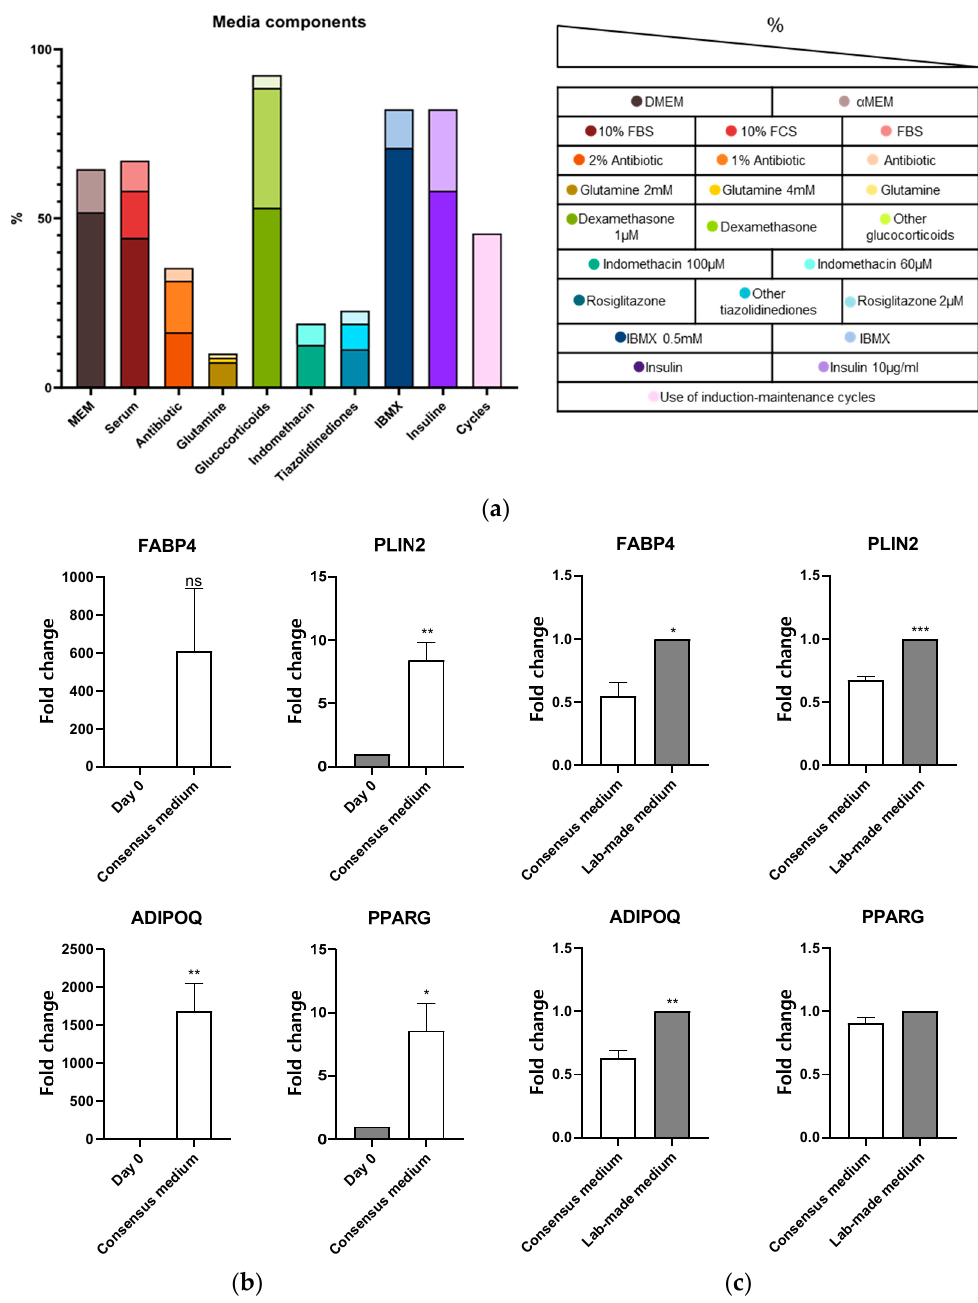
Figure 2. Design and improvement of a consensus adipogenic medium. ( a ) Literature analysis of the term “adipogenesis protocol” best results. Percentage of articles using each reagent in the most used concentrations. ( b ) Differentiation of C3H10T1/2 for 7 days with consensus adipogenic medium. FABP4, PLIN2, ADIPOQ, and PPARG marker gene expression assessed by RT-qPCR. Data coming from at least three independent experiments is presented as Fold change over day 0 and expressed as the mean ± SEM (* p < 0.05; ** p < 0.01; *** p < 0.001; **** p < 0.00001). ( c ) 7 days C3H10T1/2 adipogenic differentiation with consensus and Lab-made medium. FABP4, PLIN2, ADIPOQ, PPARG marker gene expression assessed by RT-qPCR. Data coming from at least three independent experiments is presented as Fold change over Lab-made medium and expressed as the mean ± SEM (* p < 0.05; ** p < 0.01; *** p <